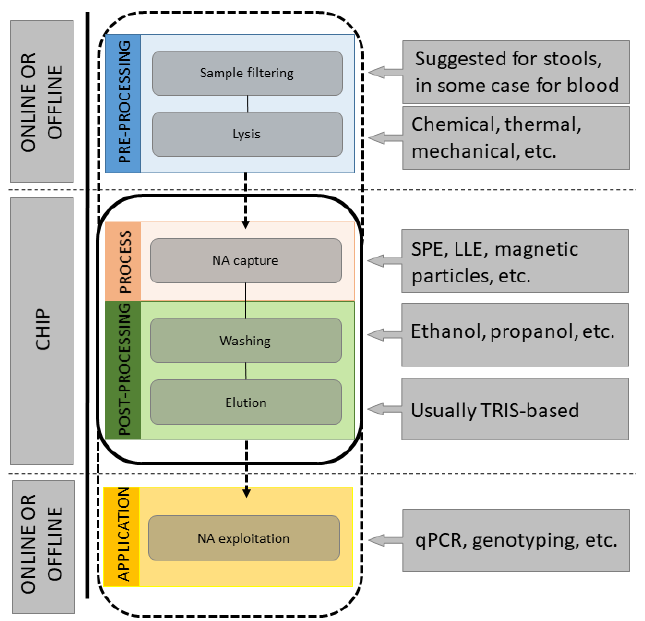
Figure 1. Theoretical scheme of a LOC for NA extraction from raw human samples. Raw samples are filtered, if necessary, and cells are lysed. NA are captured while other cellular components are removed. The successive step involves NA elution to obtain pure NA, which can be analyzed online or withdrawn for offline analyses.